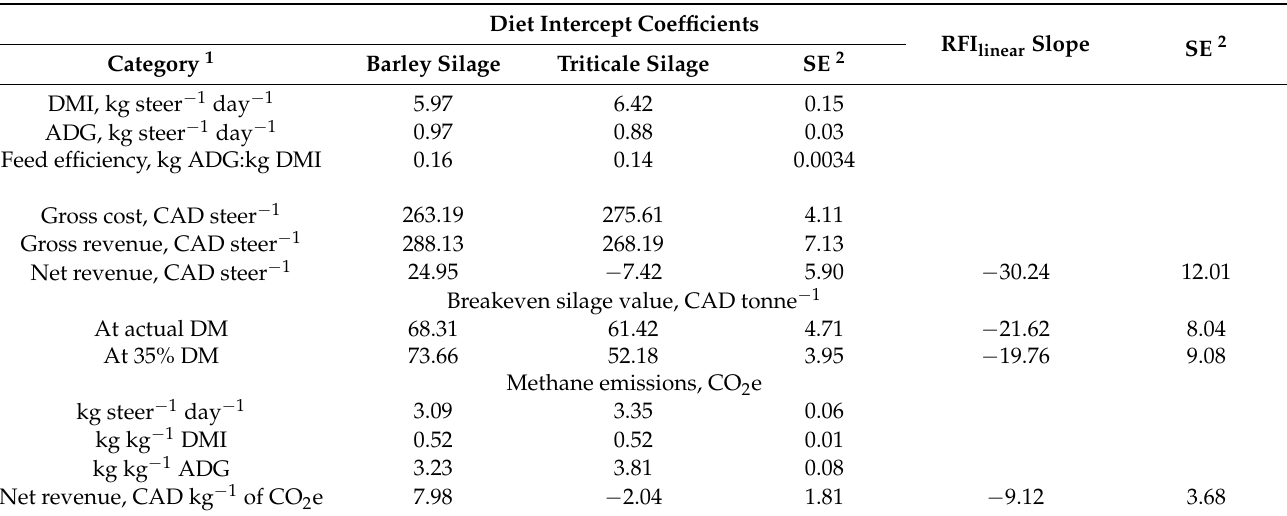
Table 4. Fitted regression equation coefficients for effects of diet, observed residual feed intake (RFI), and interactions of diet with